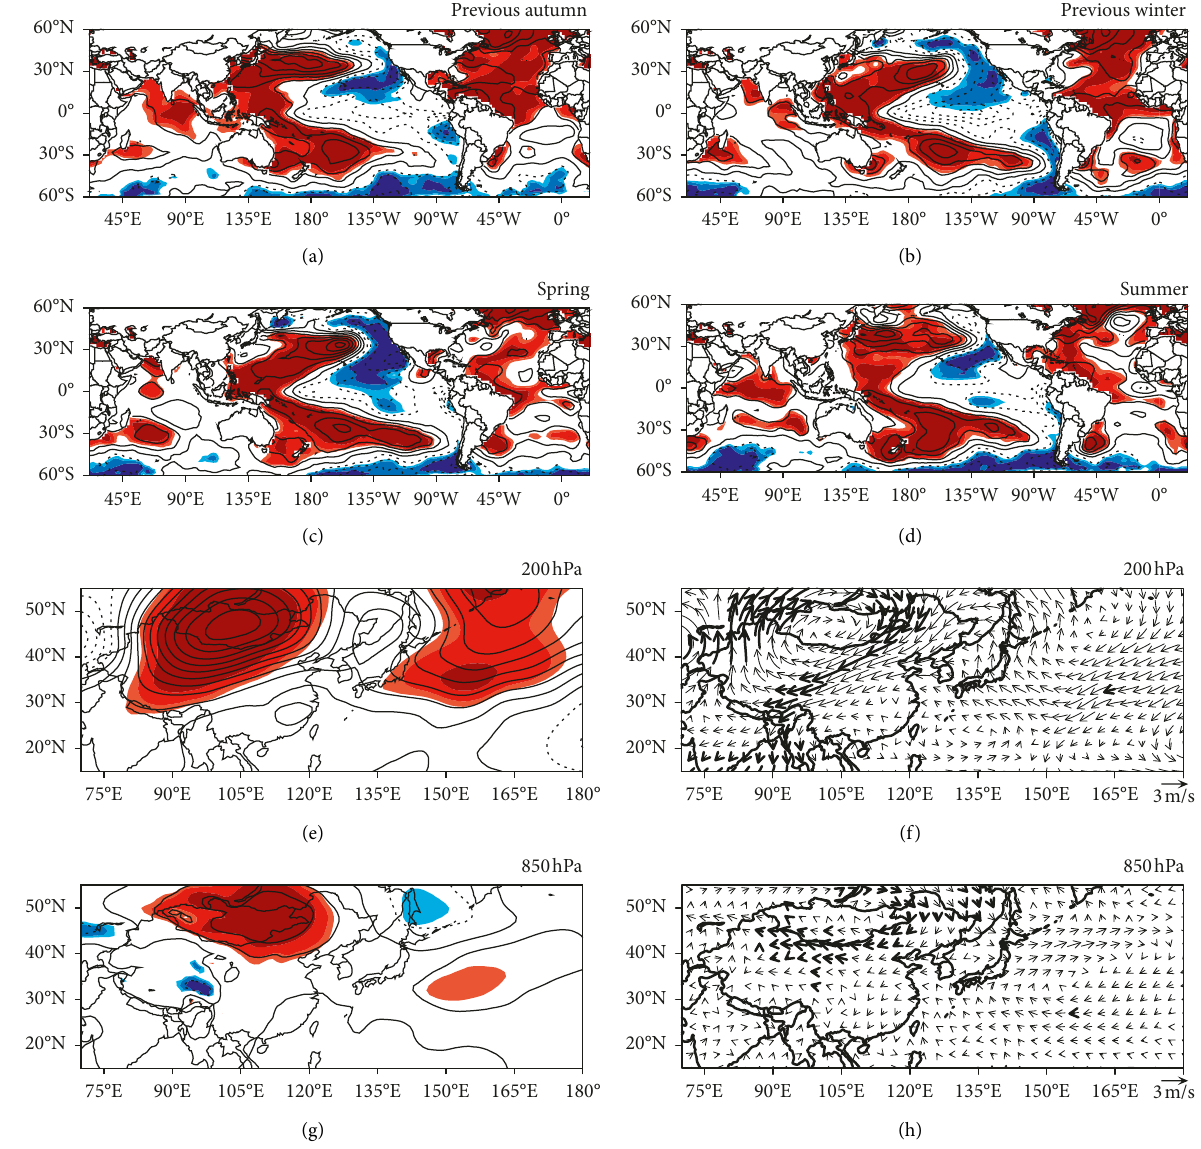
Figure 4: Differences in SST between 1999–2011 and 1983–1998 in the previous autumn (a), previous winter (b), spring (c), and summer (d) (contour interval: 0.2 ° C). Previous autumn and winter denote the seasons before one year, which means the SSTdifferences in autumn and winter between 1998–2010 and 1982–1997, respectively. Differences in geopotential height (contour interval: 5gpdm) and horizontal winds in boreal summer between 1999–2011 and 1983–1998 at 200hPa (e, f) and 850hPa (g, h). Solid (dashed) contours denote positive (negative) anomalies and thick solid lines denote zero. Red (blue) color shadings from light to dark indicate statistical significance at the 90%, 95%, and 99% levels. Thick vectors in (f) and (h) denote statistical significance at the 95%